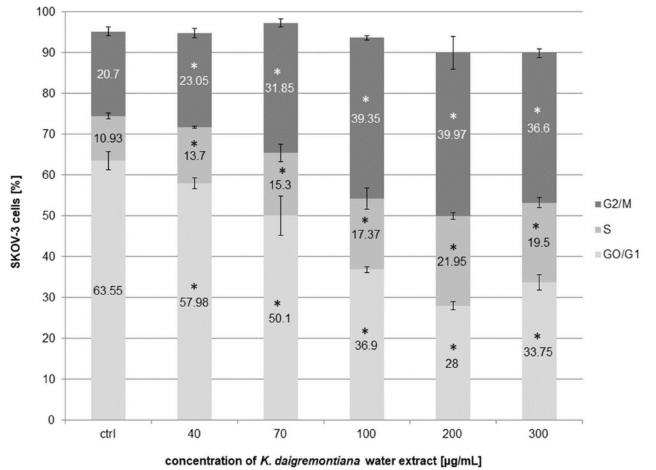
Figure 11. Kalanchoe daigremontiana water extract induced cell cycle arrest in S and G2/M phases in SKOV-3 cells. The cells were treated with the extract for 48 h and analyzed by flow cytometry. The values represent the means ± SD of three independent experiments. Error bars indicate standard deviations. Significant differences relative to the control are marked with an asterisk “*” ( p <